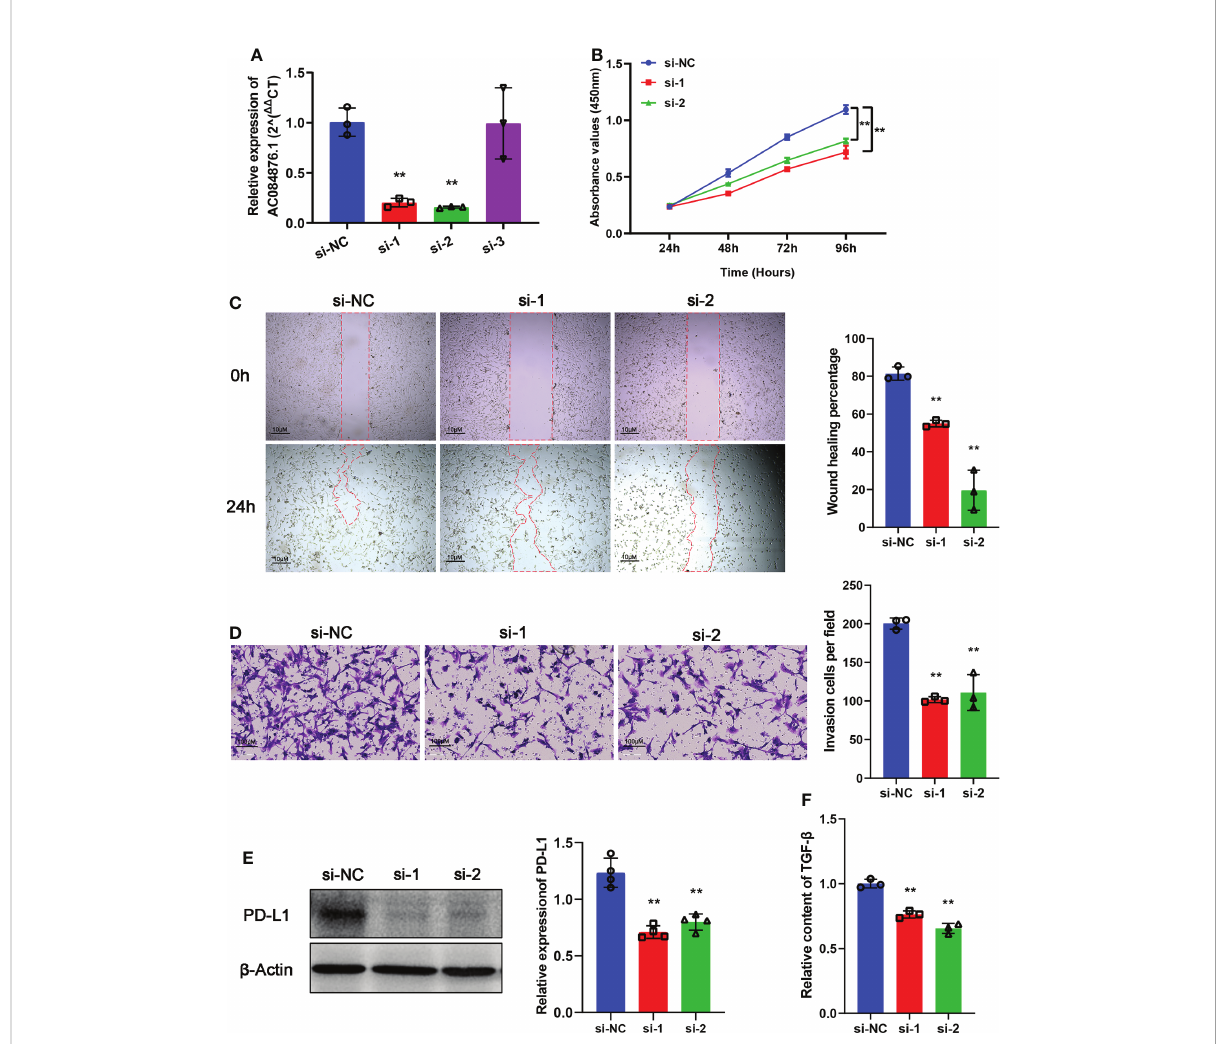
FIGURE 7 Experimental validation of AC084876.1. (A) Transfection ef fi ciency of siRNAs targeting AC084876.1 in the 786-O cell line. (B) Growth curve of AC084876.1-downregulated 786-O cell line. (C, D) Knockdown of AC084876.1 inhibited migration and invasion of the 786-O cell line. (E) Eexpression of PD-L1 decreased in the AC084876.1-downregulated 786-O cell line. (F) TGF- b secretion decreased in the AC084876.1- downregulated 786-O cell line. ** P <